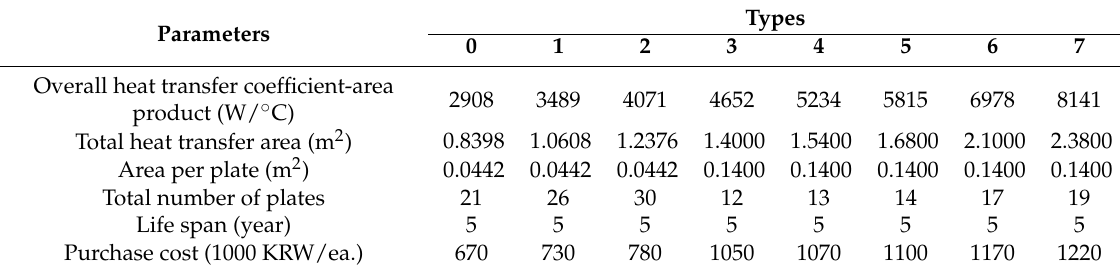
Table A2. Technical and economic parameters of heat exchangers for case study.